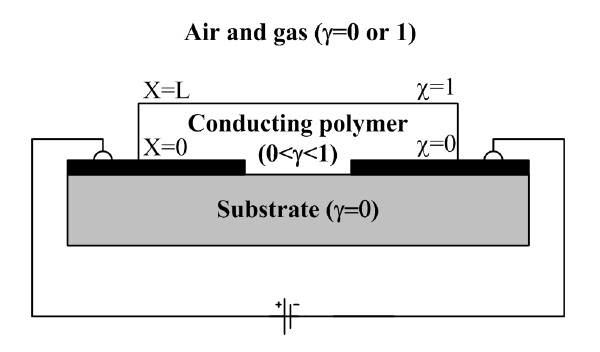
Figure 1. Device configuration used by Bartlett to investigate adsorption of conducting polymer films in chemresistor type